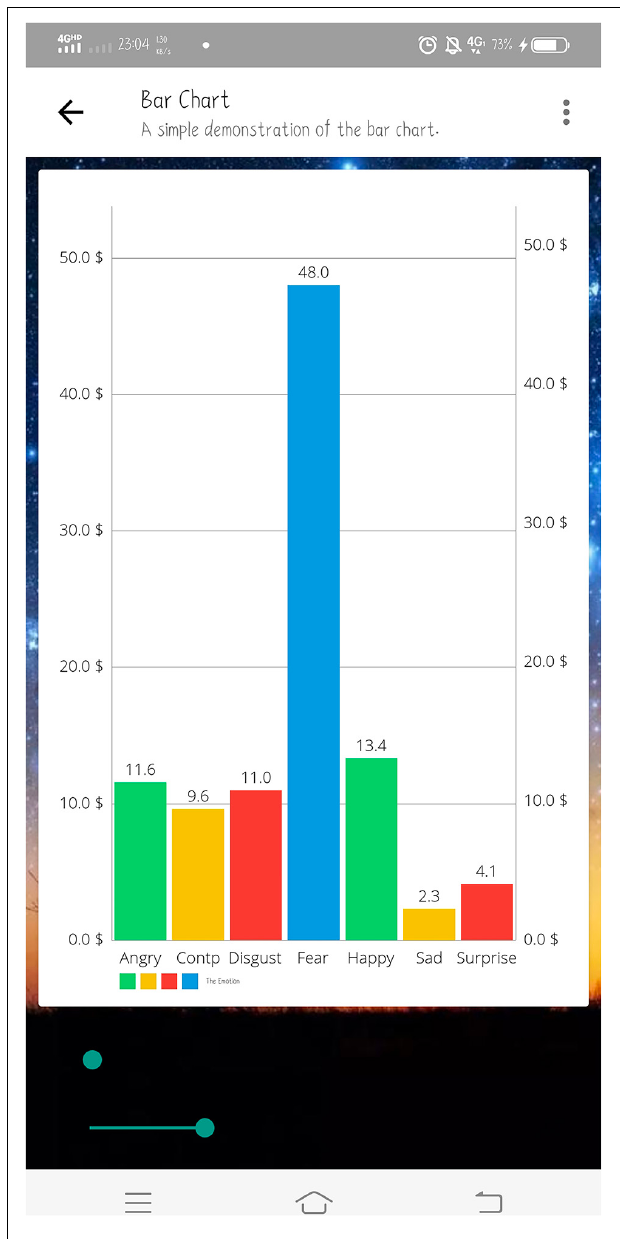
FIGURE 4 | Display of analysis results on the mobile app.